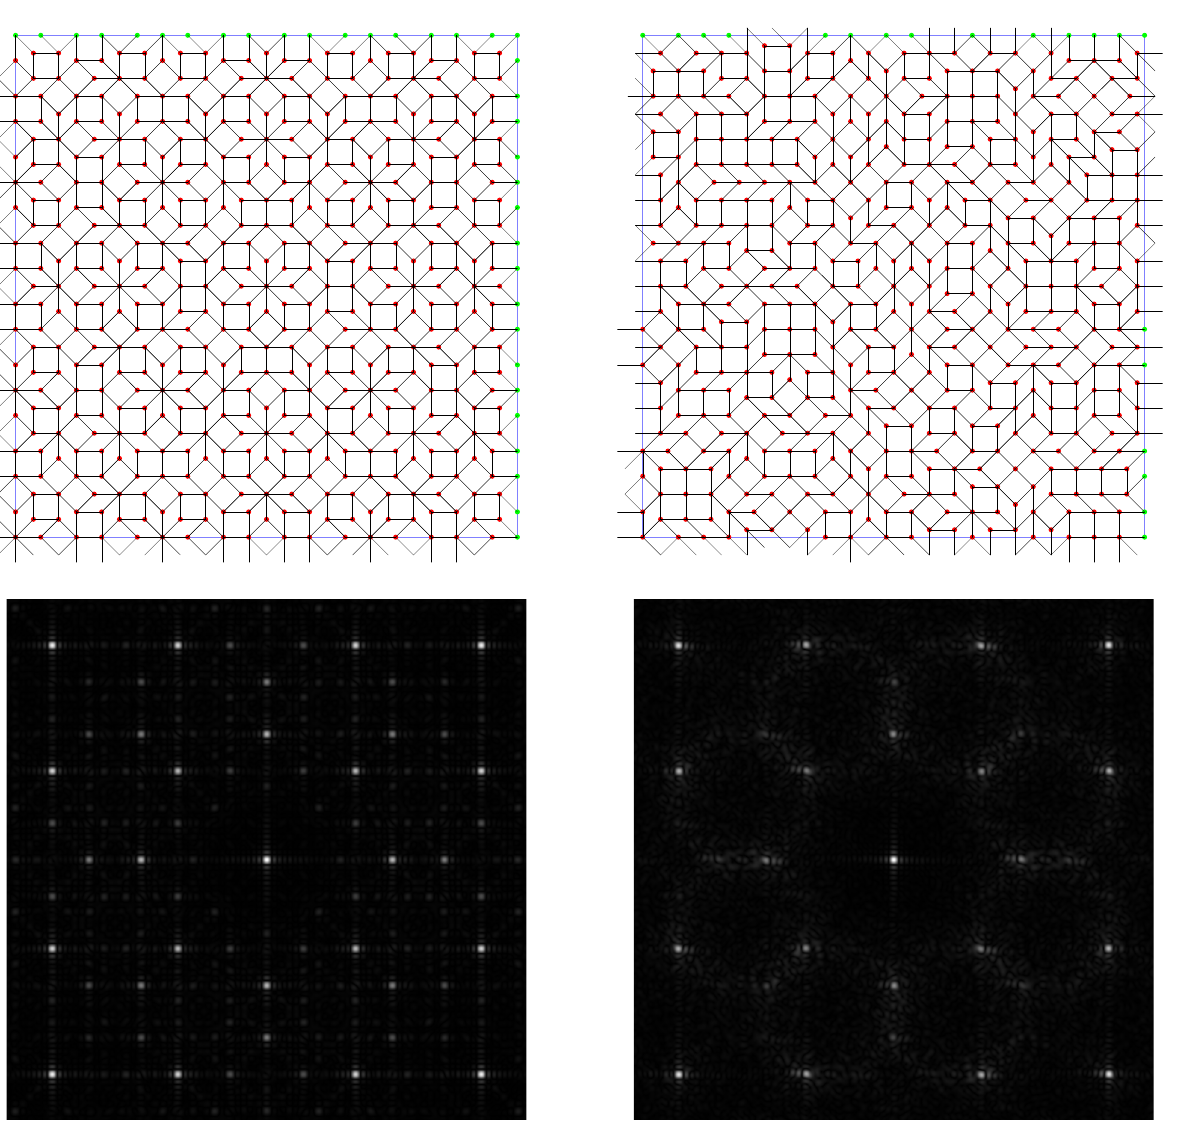
Figure 1. Finite patch of the Ammann–Beenker tiling (top) and its di ff raction (bottom)